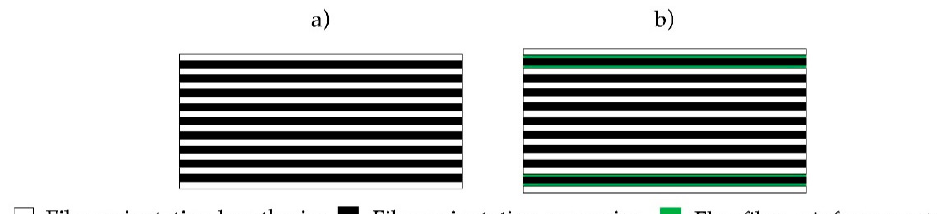
Figure 1. Veneer layup reference ( a ), with flax fiber reinforcement ( b ).